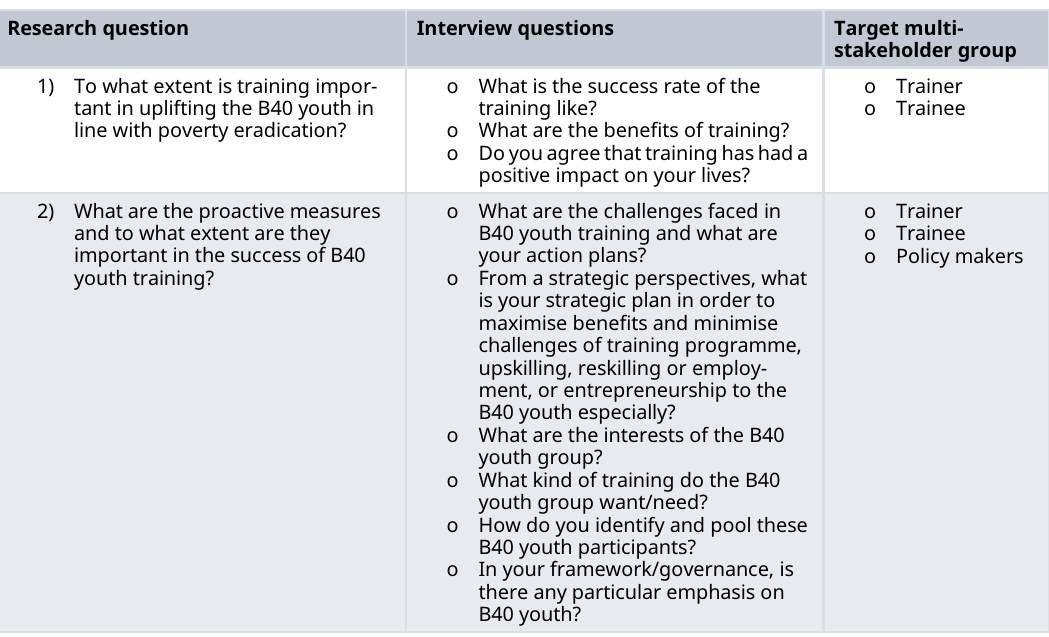
Table 2. Interview questions asked for each research question and their respective target